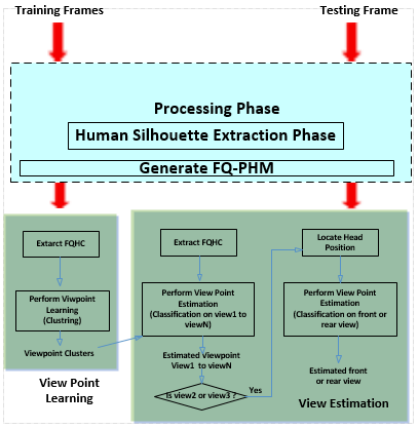
Figure 6. Example of Fuzzy view estimation framework